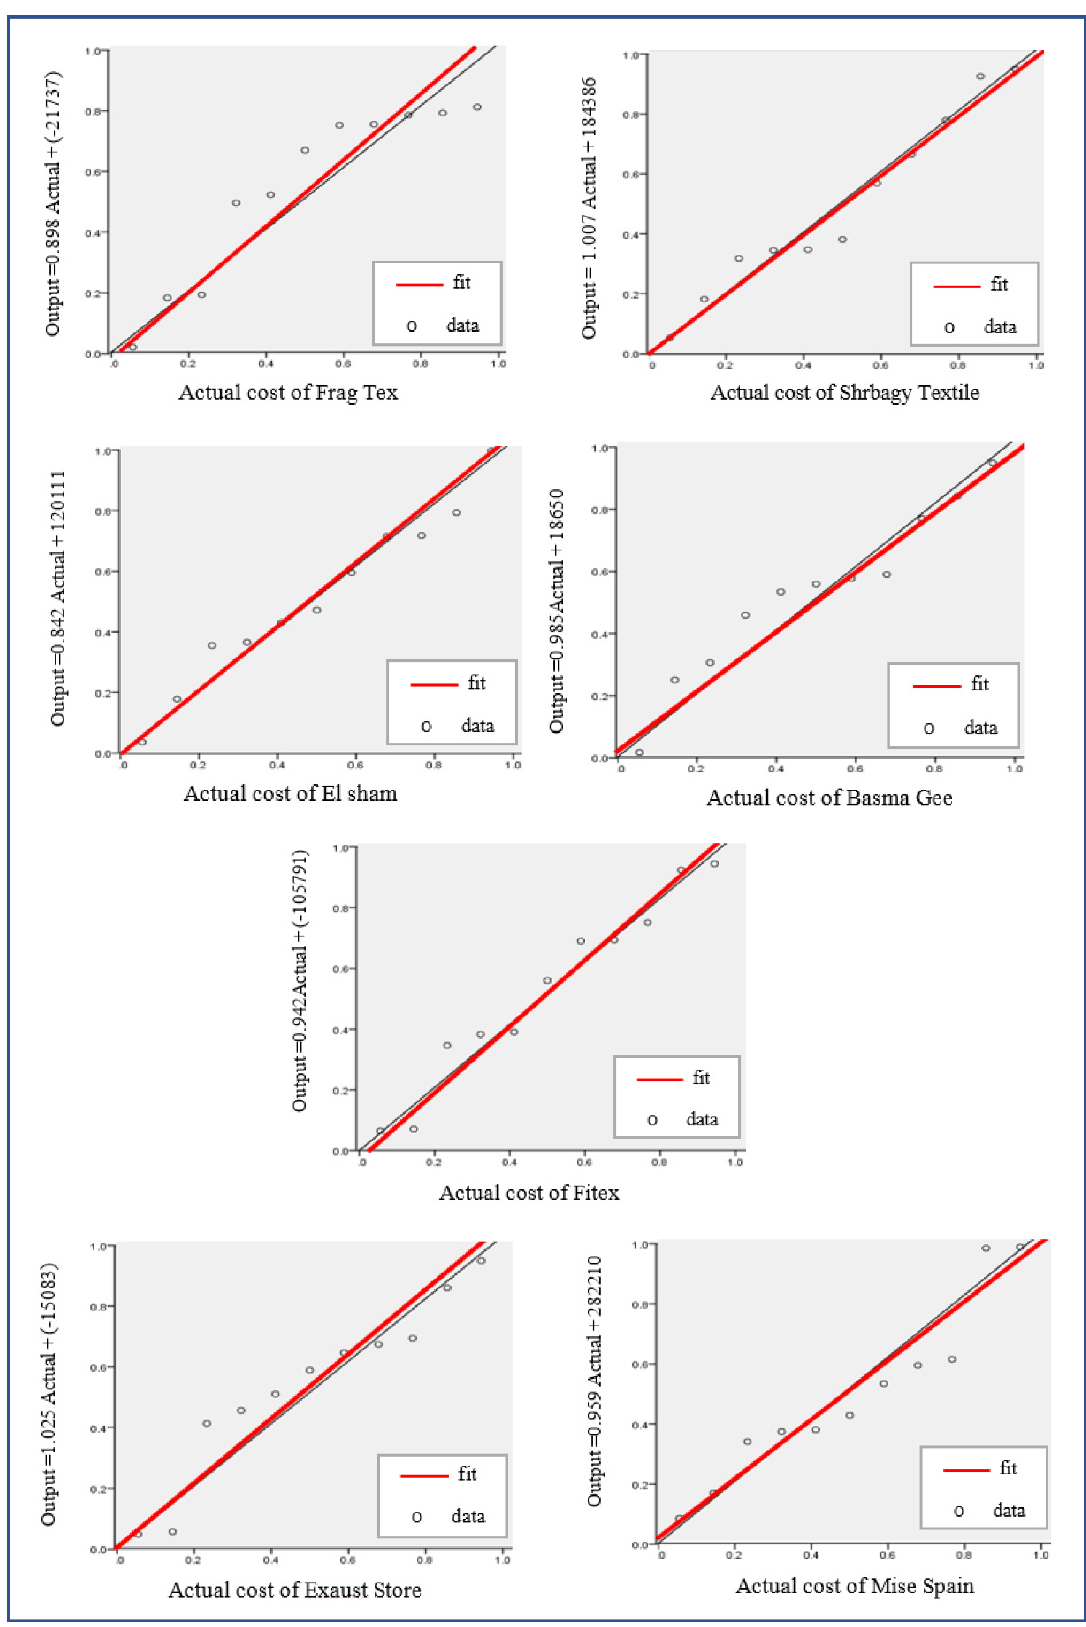
Figure 7. A regression plot between the independent variable (actual) and the dependent variable (output) for the seven case studies. (output) for the seven case